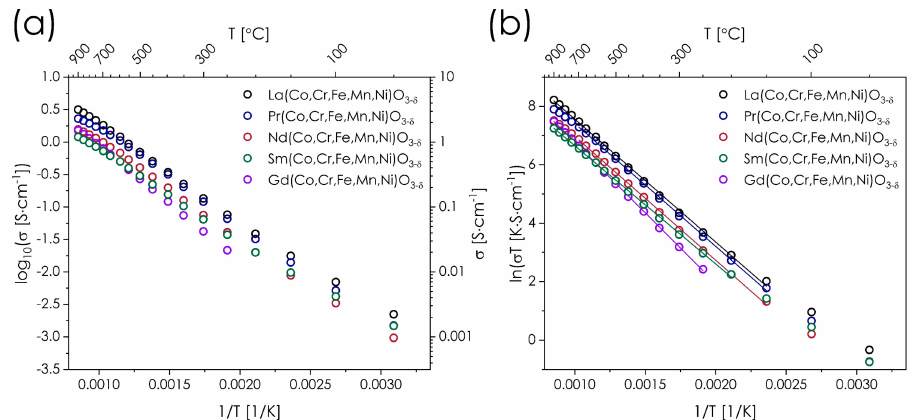
Figure 5. ( a ) Value of the total electrical conductivity of the Ln(Co,Cr,Fe,Mn,Ni)O 3 − δ series; ( b ) total electrical conductivity of the Ln(Co,Cr,Fe,Mn,Ni)O 3 − δ series presented in Arrhenius coordinates. The linear fits used for the determination of energy of activation are also presented.